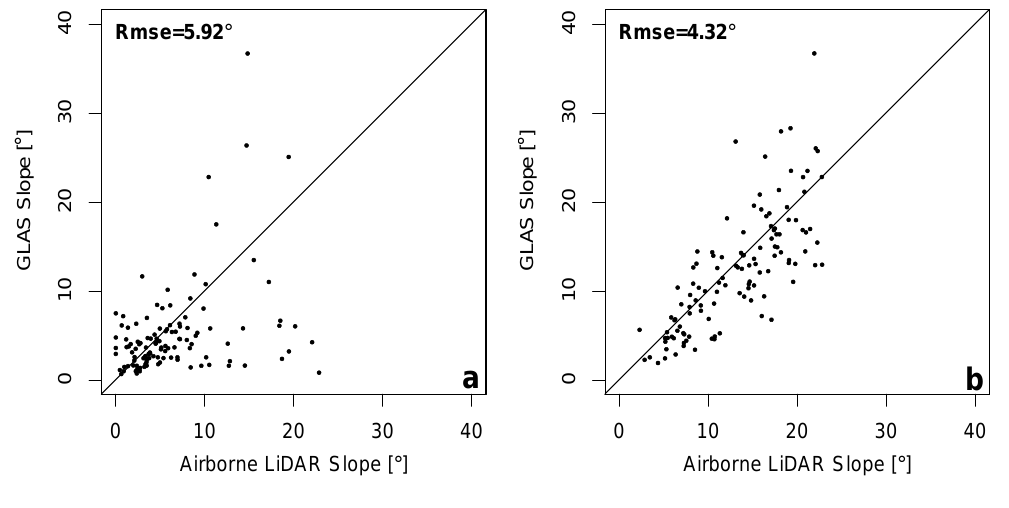
Figure 9. Comparison of filtered ALS and ISM slope (according to Section 3.1.2) with identical sample sizes for ( a ) Tharandt and ( b ) Tumbarumba. Dense/multi-layered vegetation is present at Tharandt, in contrast to an open canopy and complex terrain combination at